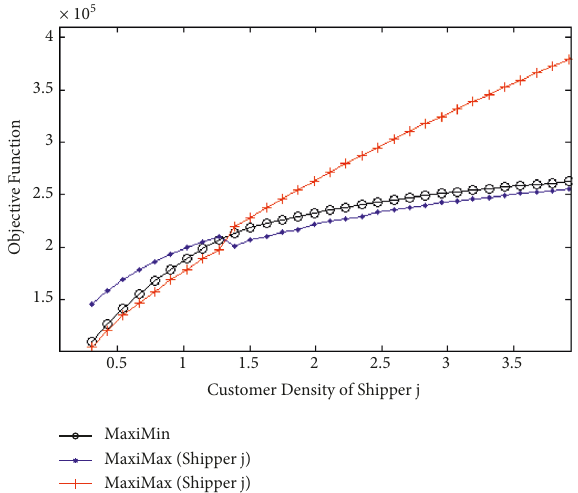
Figure 9: Savings curve with respect to customer density of shipper j .